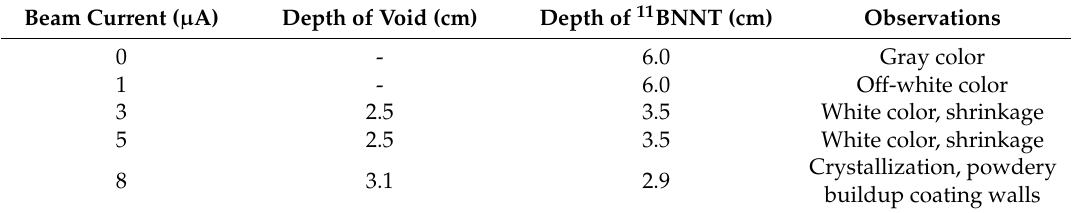
Table 1. Material shrinkage measurements and visual observations for the BN-124 target.